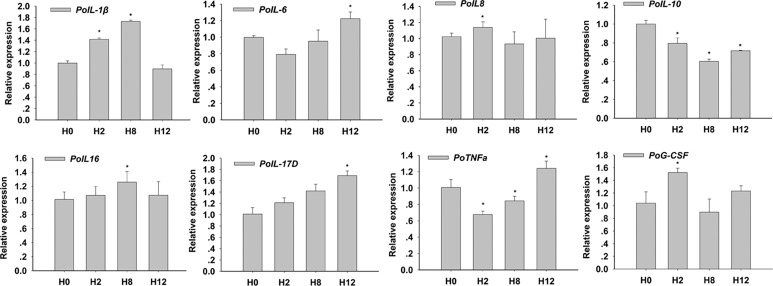
Relative expression of interleukin 1β (IL-1β), IL-6, IL-8, IL-10, IL-16, IL-17D, tumor necrosis factor α (TNF-α), and granulocyte colony-stimulating factor (G-CSF) in posterior intestines of E. tarda-infected P. olivaceus. The data present the mean ± standard error (SE) derived from triplicate experiments. * represents the values that are significantly different (p < 0.05) from H0 time point.